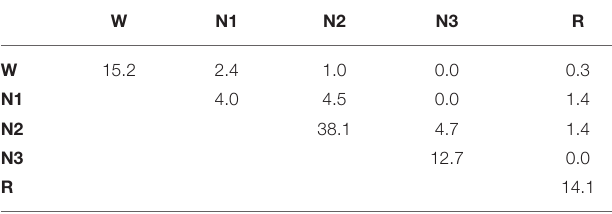
TABLE 3 | Percentage of epochs per sleep stage in a weighted pairwise comparison between